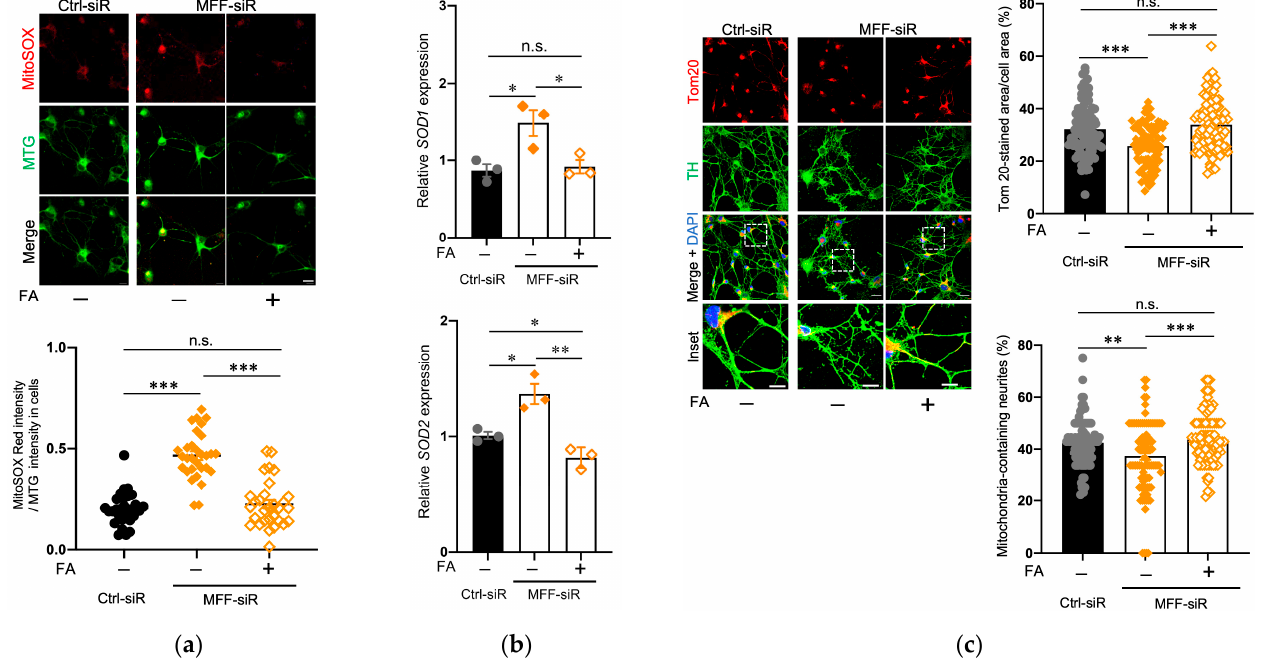
Figure 5. FA supplementation improved mitochondrial ROS levels and mitochondrial amount and distribution in DNs with MFF insufficiency. Stem cells from human exfoliated deciduous teeth were differentiated into DNs either in the absence or presence of FA. ( a ) DNs were stained with MitoSOX Red and MTG. Scale bar = 20 μ m. To measure the ROS level per mitochondrion, the fluorescence intensity of MitoSOX Red was divided by that of MTG. The mean ± SEM was taken from three independent experiments. n.s., not significant, *** p < 0.001. ( b ) Superoxide dismutase 1 and 2 ( SOD1 and SOD2 ) mRNA expression in DNs was measured using RT-qPCR. The mean ± SEM was taken from three independent experiments. n.s., not significant, * p < 0.05, ** p < 0.01. ( c ) DNs were stained with anti-Tom20 and anti-TH antibodies and counterstained with DAPI. Scale bars = 20 μ m. Boxed regions on the merged images are shown at a greater magnification in the lower panels. Scale bars = 10 μ m. Tom20-stained area per cell area and the percentage of mitochondria-containing neurites were measured. The mean ± SEM was taken from three independent experiments. n.s., not significant, ** p < 0.01, *** p < 0.001.